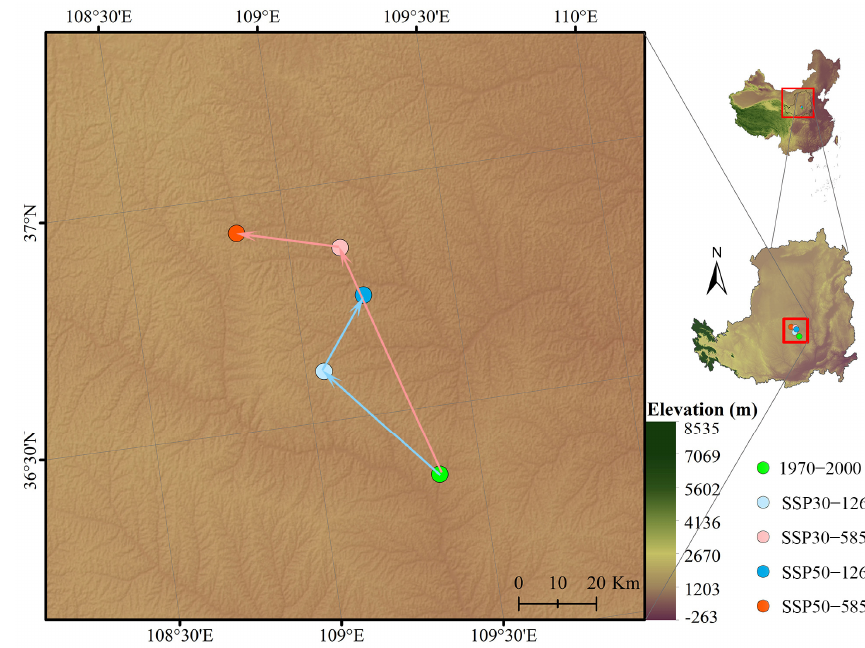
Figure 4. The suitability centroids of apple trees on the Loess Plateau.